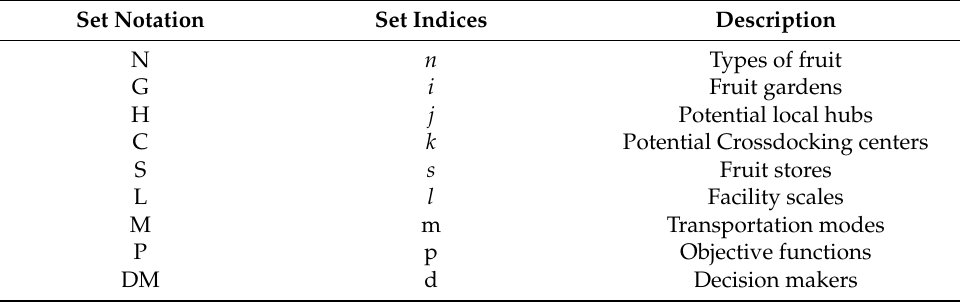
Table 1. List of sets.